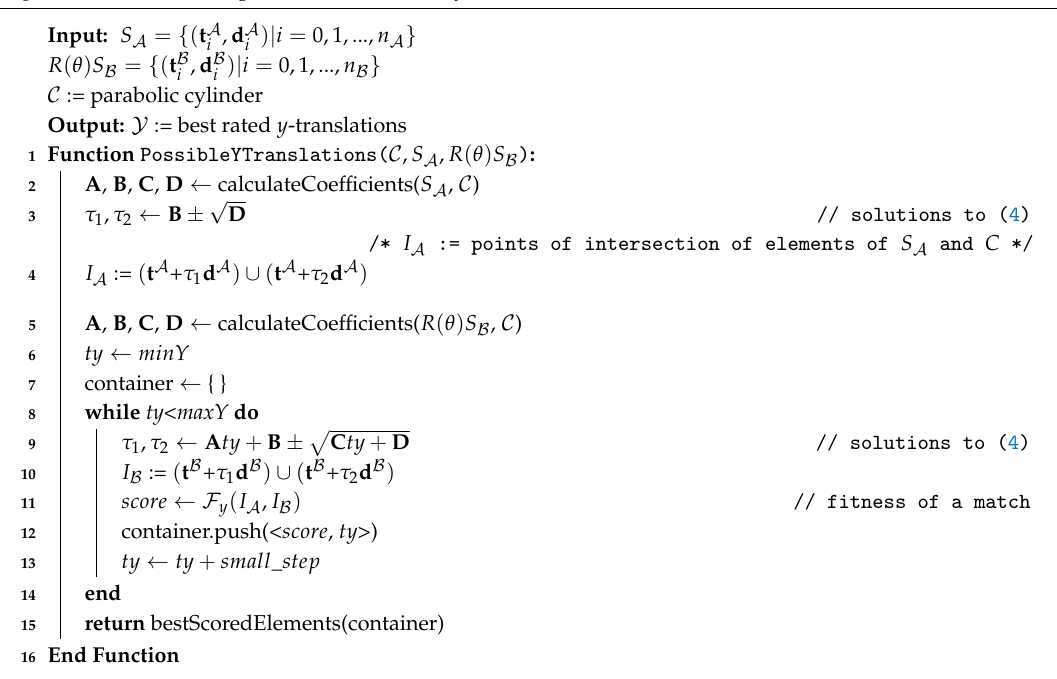
Algorithm 2 : Determining best translation over y